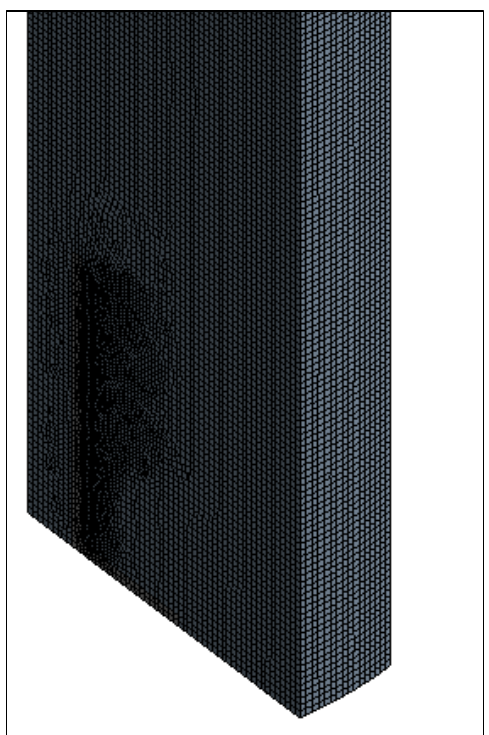
Figure: 2(b) Schemtic diagram of the computational domain and HS. Figure: 3(a) hexahedral grids for computation